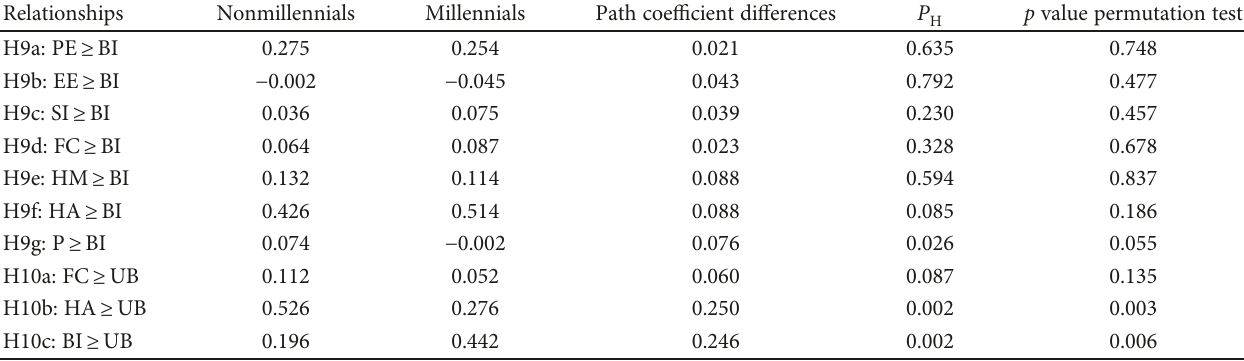
Table 7: Multigroup comparison for the intention to use a smartphone in-store: millennials vs. nonmillennials.